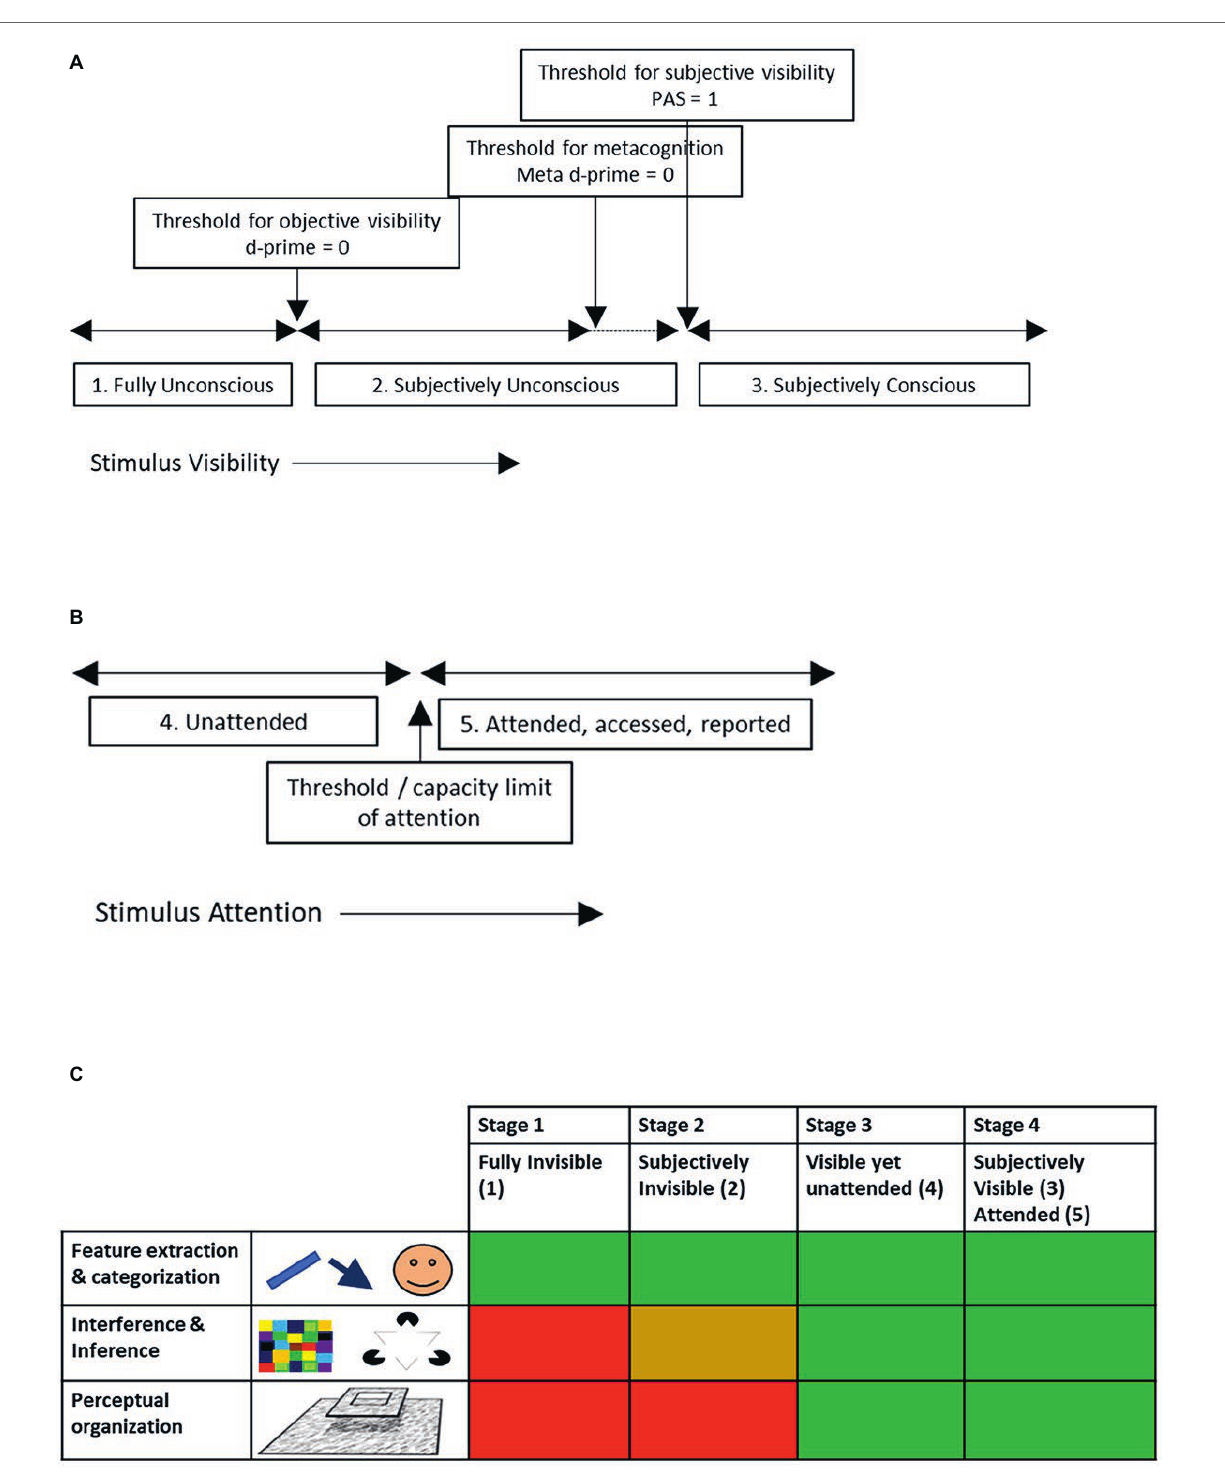
FIGURE 1 | Visual operations during stages of unconscious to conscious and attentive (visual) processing. (A) Depending on stimulus manipulations like masking, CFS, etc., stimuli may be consciously visible or not. Shown are the different thresholds for conscious visibility, depending on the method used to “ask” subjects whether the stimulus was seen or not. (B) Depending on attention, stimuli may become consciously accessed and reported or not. There is typically a capacity limit for how much can be attended, accessed or reported. (C) Table showing which of three categories of visual functions are or are not executed during the different stages of unconscious/conscious/unattended/attended vision. A red box indicates that the functions are not executed, green that they are, yellow that there are mixed results or that some functions in this category are executed while others are